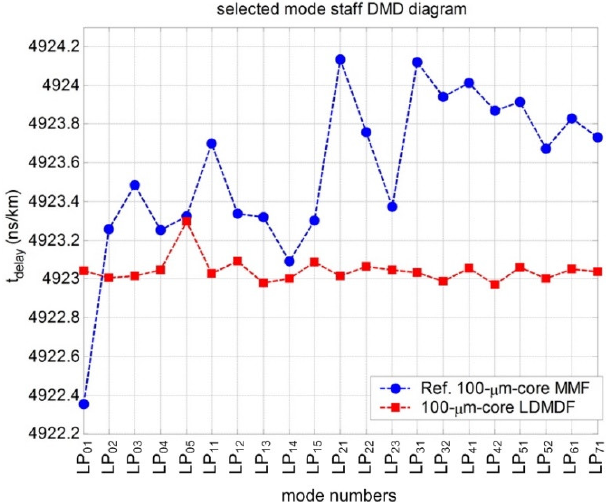
Figure 5. Optimized graded refractive index profile for a 100 μm core low differential mode delay fiber (LDMDF).